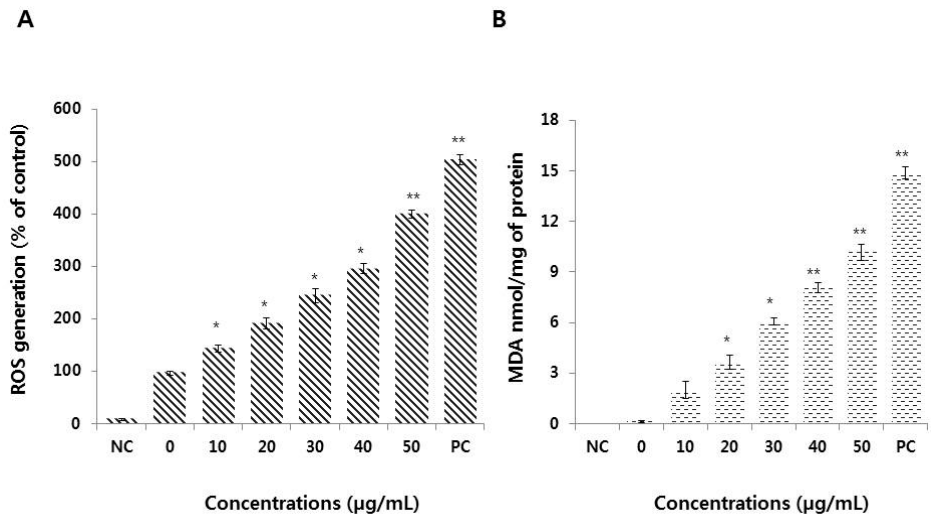
Figure 4. Measurement of reactive oxygen species (ROS) generation and malondialdehyde (MDA) levels in HEK293 cells. ( A ) HEK293 cells were treated with or without graphene oxide for 24 h and ROS generation was then measured using DCFH-DA. ( B ) HEK293 cells were treated with graphene oxide for 24 h. Lipid peroxidation was determined by the reaction of MDA with thiobarbituric acid (TBA) that forms a colorimetric (532 nm) / fluorometric (excitation and emission wavelengths of 532 nm and 553 nm, respectively) product, the quantity of which is proportional to the MDA present. The results are expressed as the means ± standard deviation of three independent experiments. There were significant di ff erences in the levels of ROS generation and lipid peroxidation in graphene oxide-treated cells compared to untreated cells. * p < 0.05 was considered significant; ** p < 0.01 was considered highly significant and *** p < 0.001 was considered very highly significant.